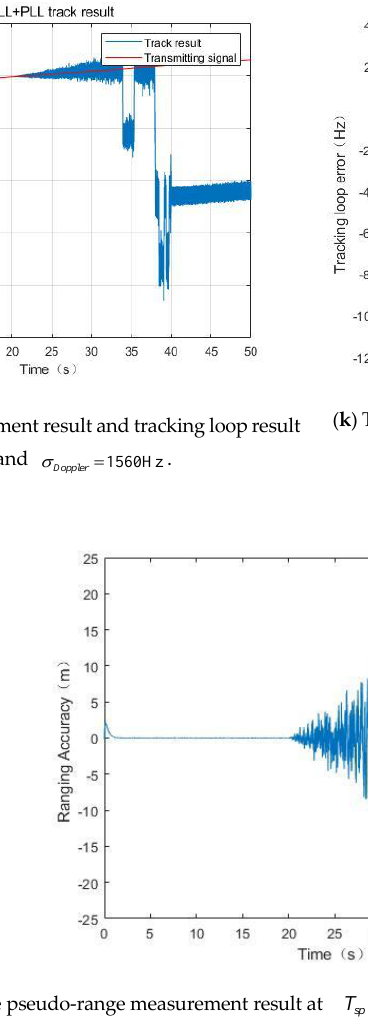
Figure 6. The measurement results when CNR = 60 dBHz. Excessive extrapolation errors of the Doppler frequency and ranging during the TDD switching period will cause loop unlocking and reacquisition. The simulation shows that if the